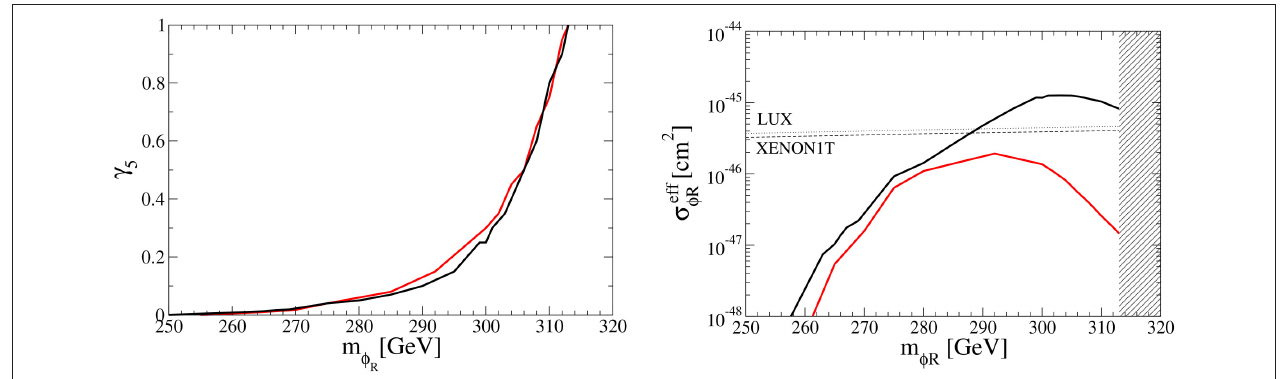
0.12. (Right) The relation between the m φ and the effective cross sections given in Equation (24). ∼